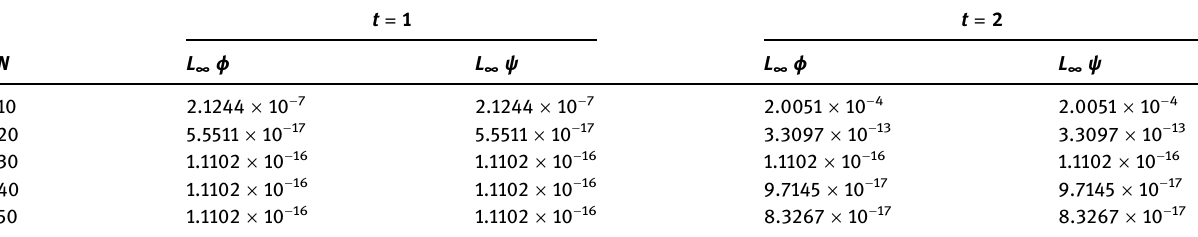
Table 3: Comparison of L ∞ errors for ϕ and ψ components at di ff erent grid points regarding Example 1 t = 1 t = 2